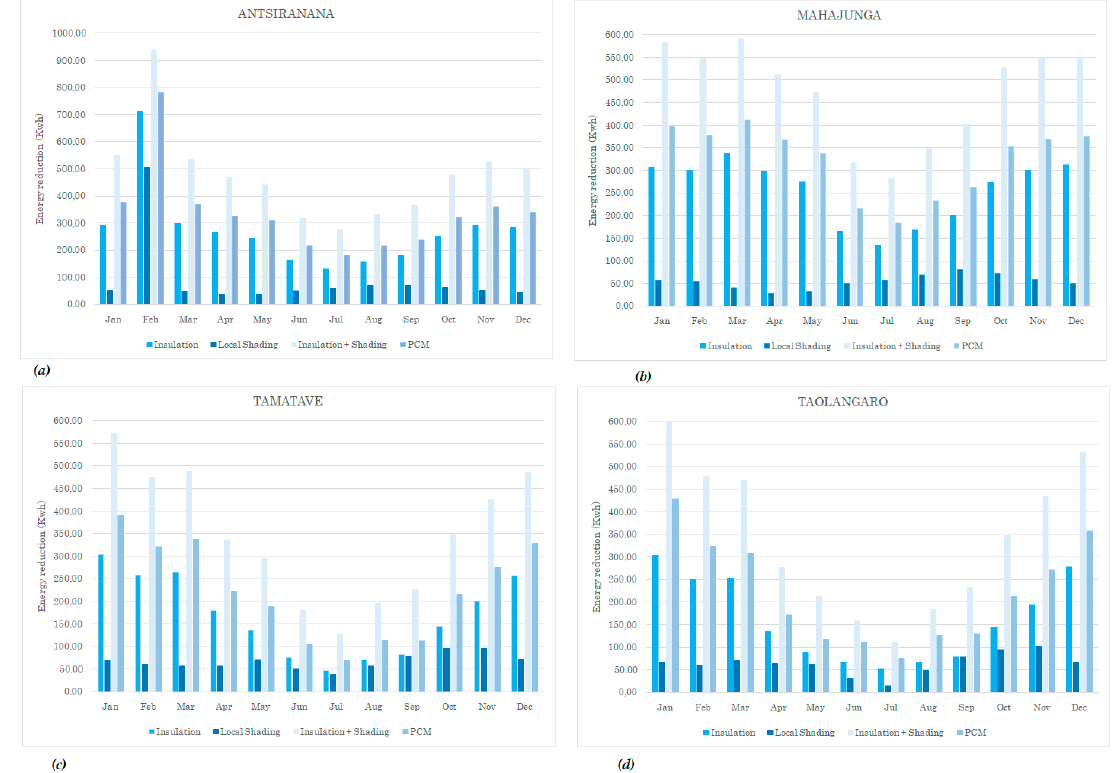
Figure 8. Energy reduction in the four cities with application of passive strategies during two seasons.